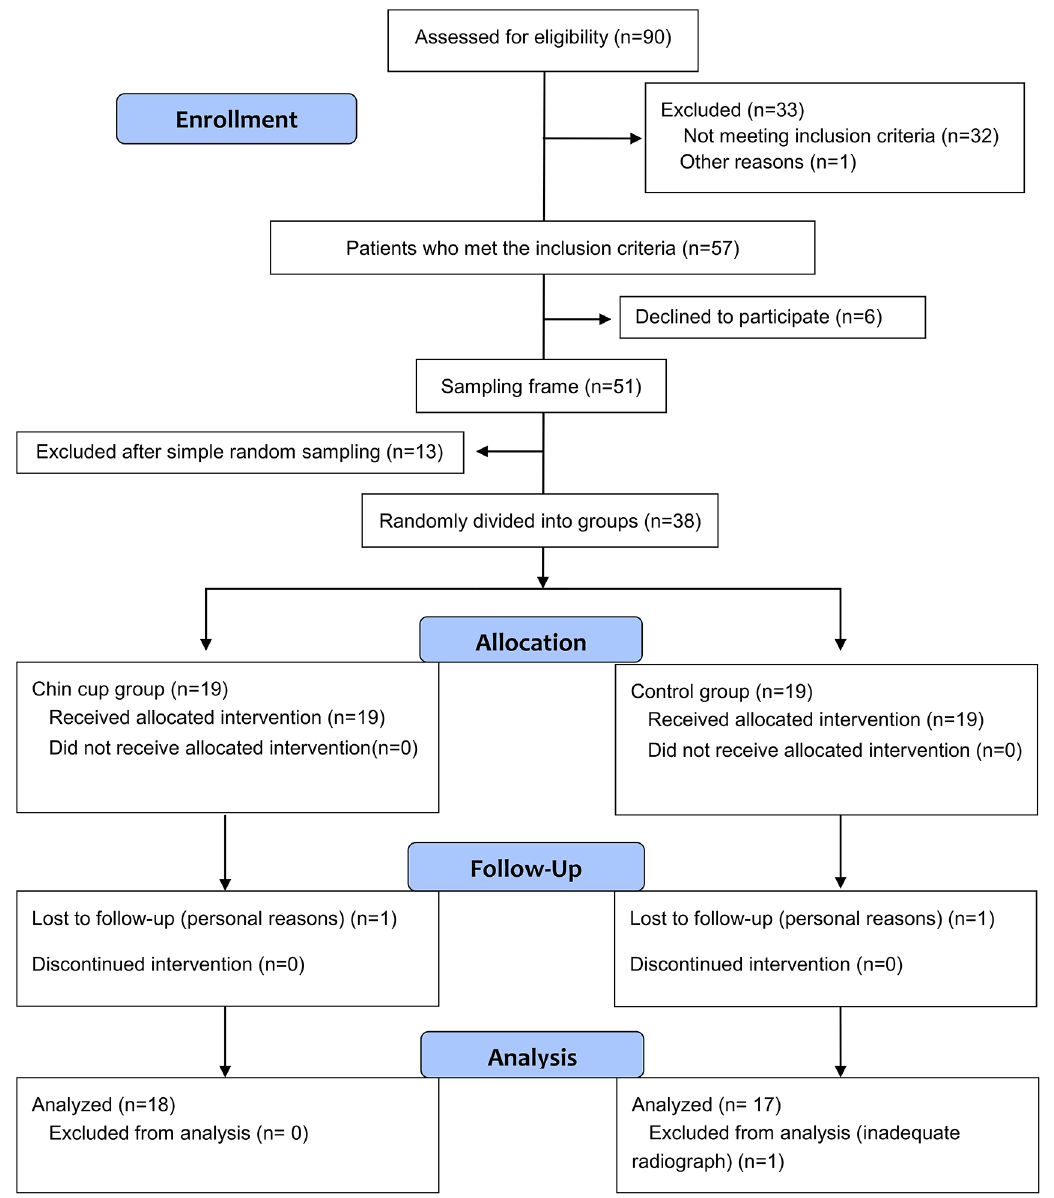
Figure 1. CONSORT flow diagram of patients ’ recruitment, follow-up and entry into data